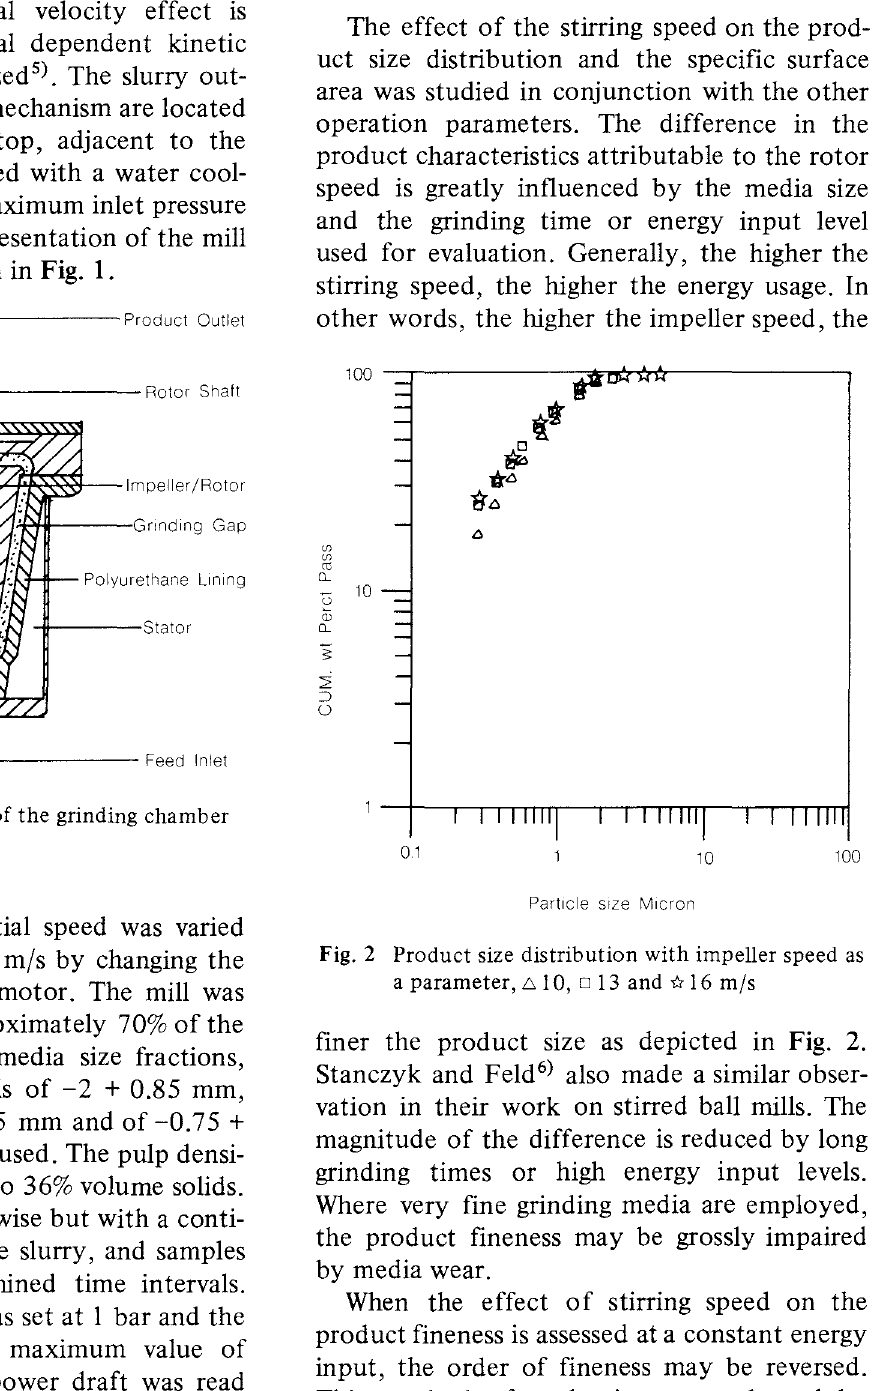
Fig. 1 Cross-sectional view of the grinding chamber of CoBall mill